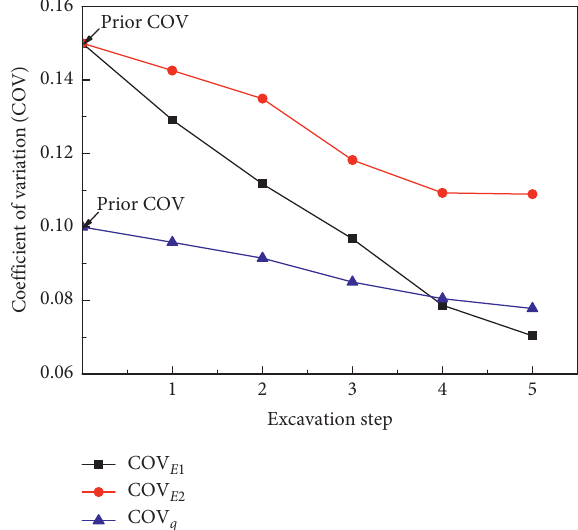
Figure 6: Comparison of the posterior PDFs of Young’s modulus of gravel layer for different excavation steps.